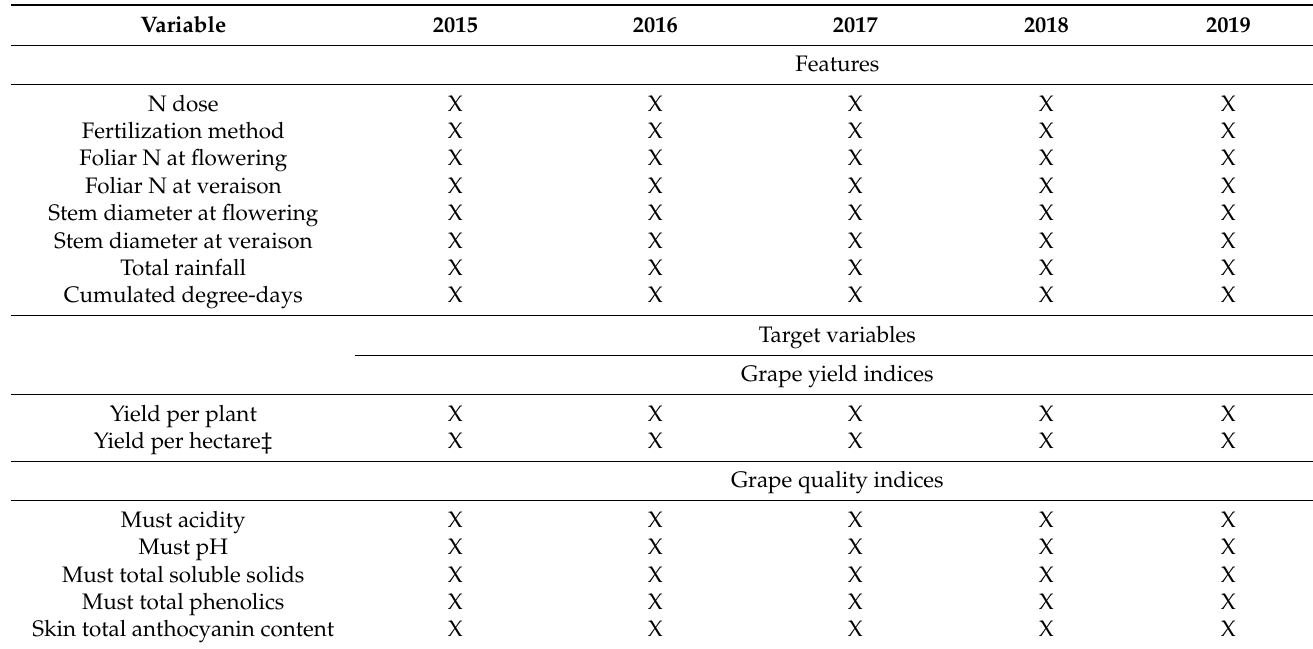
Table 6. A list of the variables during the experimental